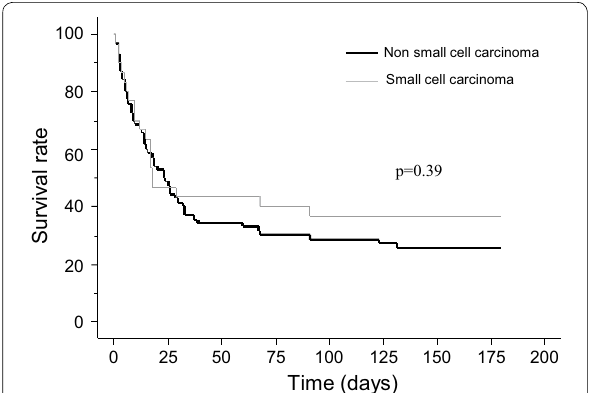
Fig. 2 Kaplan–Meier survival curve according to the cancer